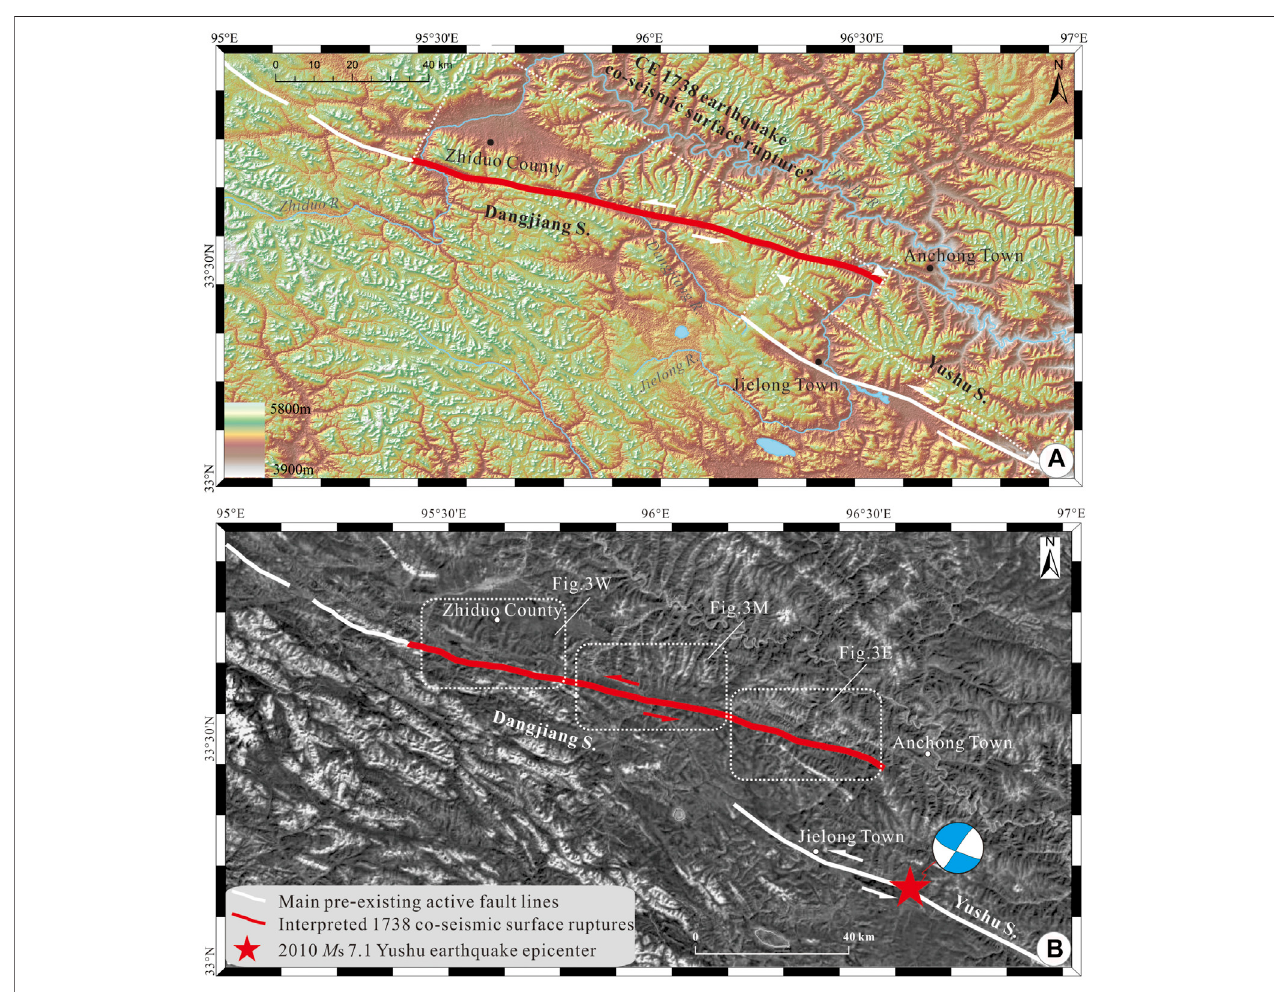
FIGURE 2 | Satellite images showing the tectonic topographies of the NW continuation of the Xianshuihe Fault Zone (XFZ). (A) Color relief map showing that the DangjiangFaultZone(DJF)andtheYushuFaultZone(YFZ)aredistributedinarightstepobliquepatternintheplaneandthattheDJFisdevelopedalongalineartectonic valley.Theinsetlegendatthelowerleftshowstherangeoftopographicreliefheightvariation. (B) GoogleimageshowingthreekeysubstudyareasalongtheDJF.Thered linerepresentstheco-seismicsurfacerupturezoneoftheCE1738Dangjianghistoricalearthquake(Zhou,etal.,1997;Linetal.,2011),whiletheredstarrepresents the epicenter of the 2010 M s 7.1 Yushu earthquake (modi fi ed from Lin et al., 2011; Li et al., 2012). The beach ball at the bottom right represents the focal-mechanism solution (Li et al., 2012), which indicates that the 2010 M s 7.1 Yushu earthquake is mainly sinistral shear rupture.